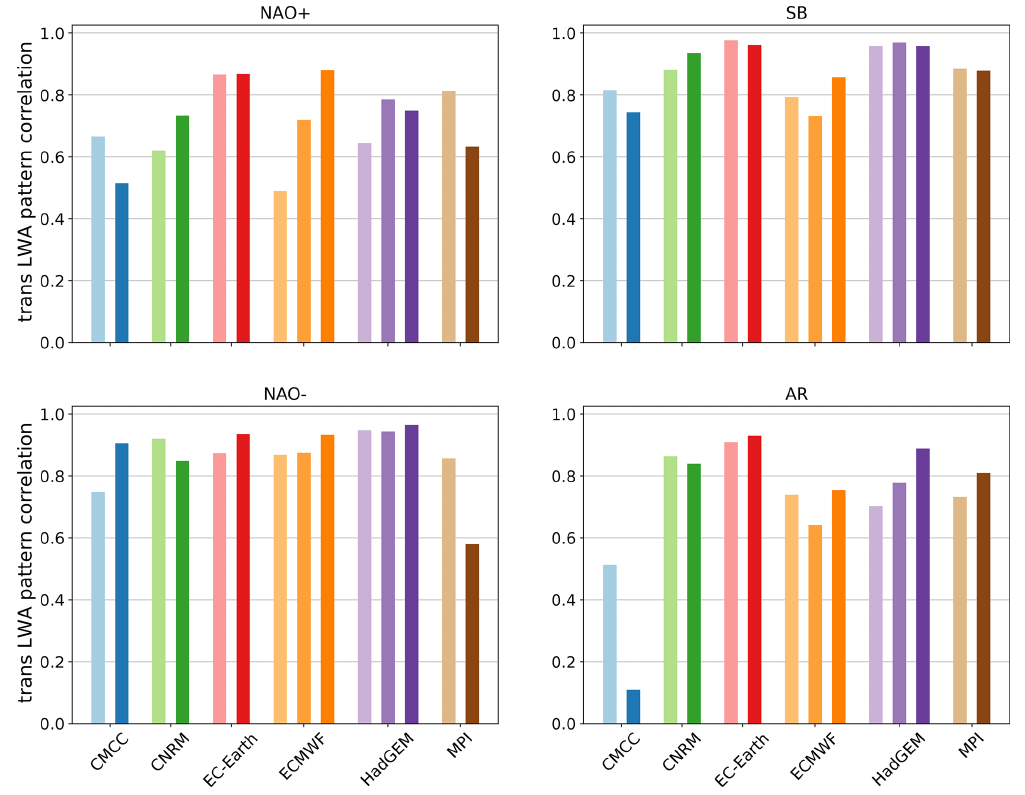
Figure 7. Pattern correlation of transient LWA on the 320K isentropic surface associated with the four WRs over the EAT sector during winter. Lighter colours are the LR simulations whereas darker colours are the HR